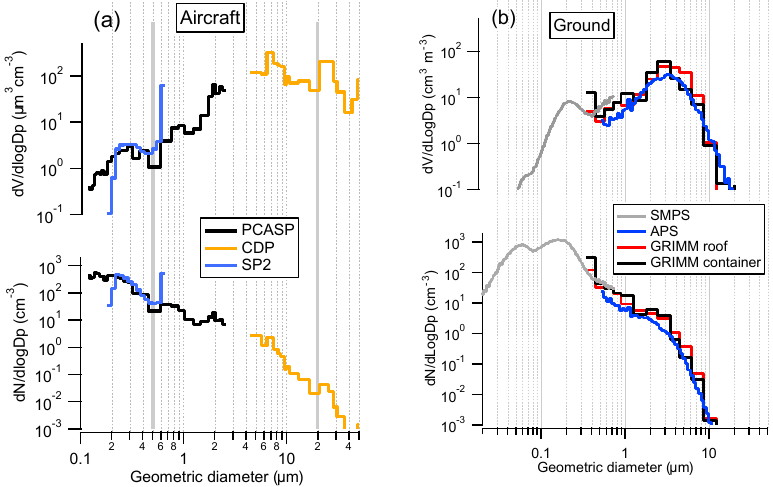
Figure 2. A typical example of size distributions for B928 SLR4 (see Fig. 7) at 4km altitude on 16 August and ground experiment Period I (see Fig. 10) during 10–13